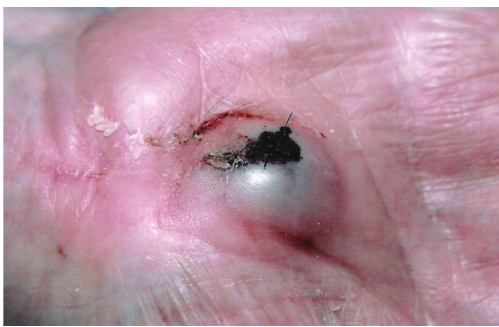
Figure 2: Coil in place in the pseudoaneurysm.